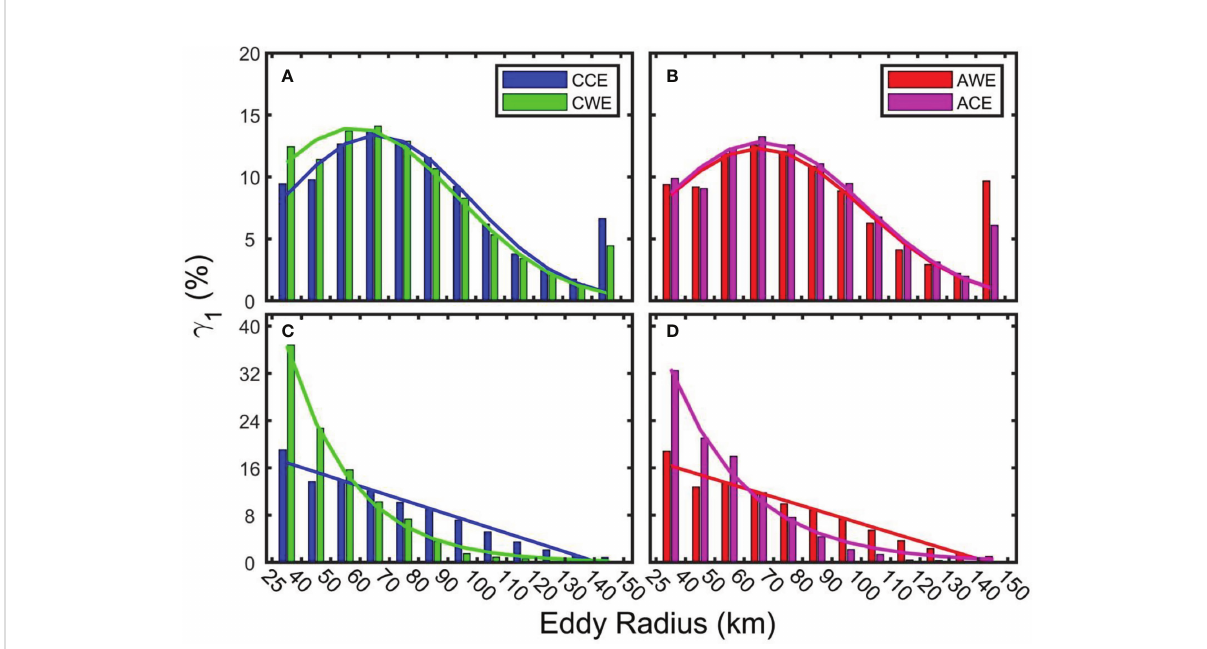
FIGURE 5 Statistical histogram of eddy radius at the sea surface (A, B) and 1,000 m (C, D) . Blue, red, green, and magenta curves represent cyclonic cold- core eddy, anticyclonic warm-core eddy, cyclonic warm-core eddy, and anticyclonic cold-core eddy,